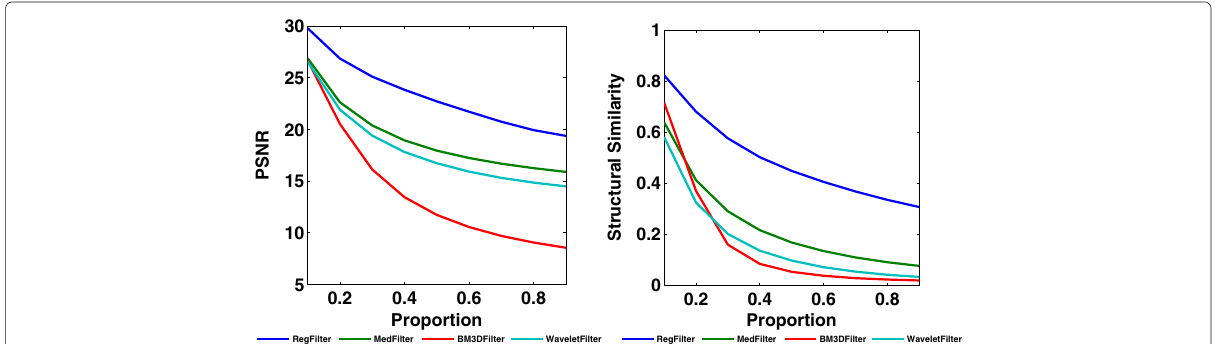
Fig. 6 Average denoised PSNR and average denoised SSIM using Median, BM3D, wavelet and regression filters for stripped noise versus noise level p ; averaging over six